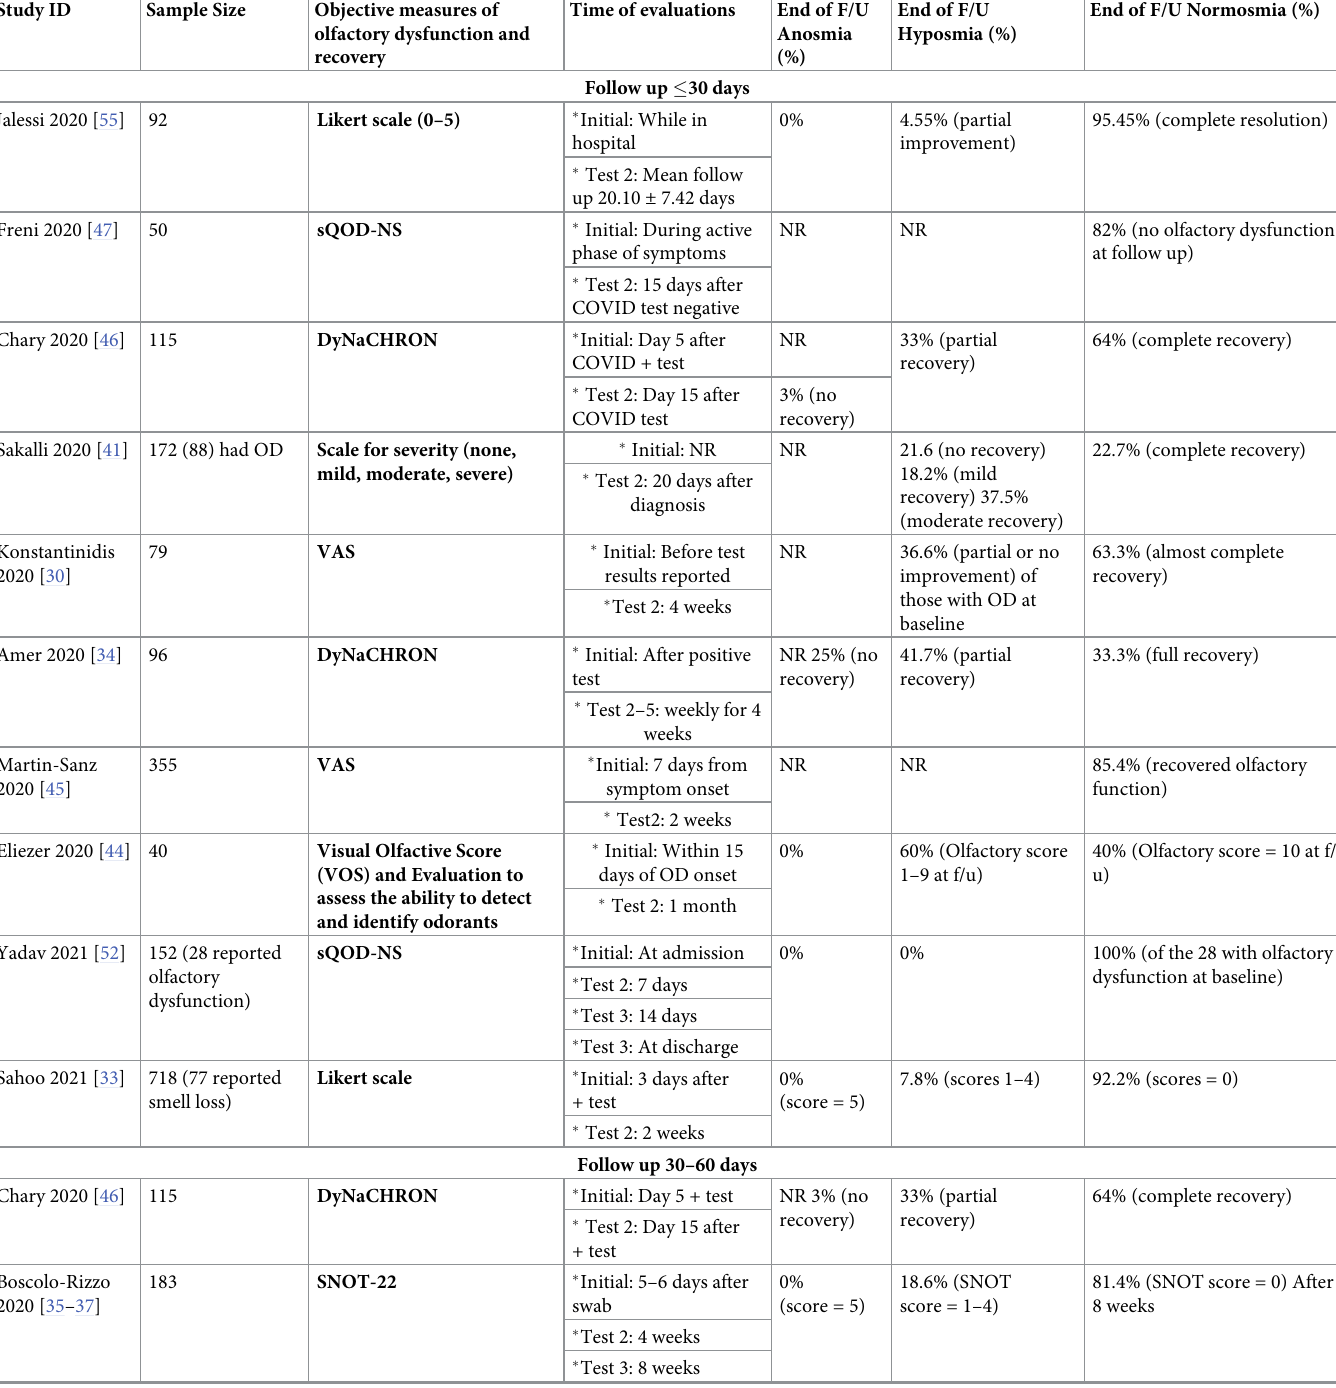
Table 5. Olfactory recovery at the end of follow up in studies that used subjective olfactory